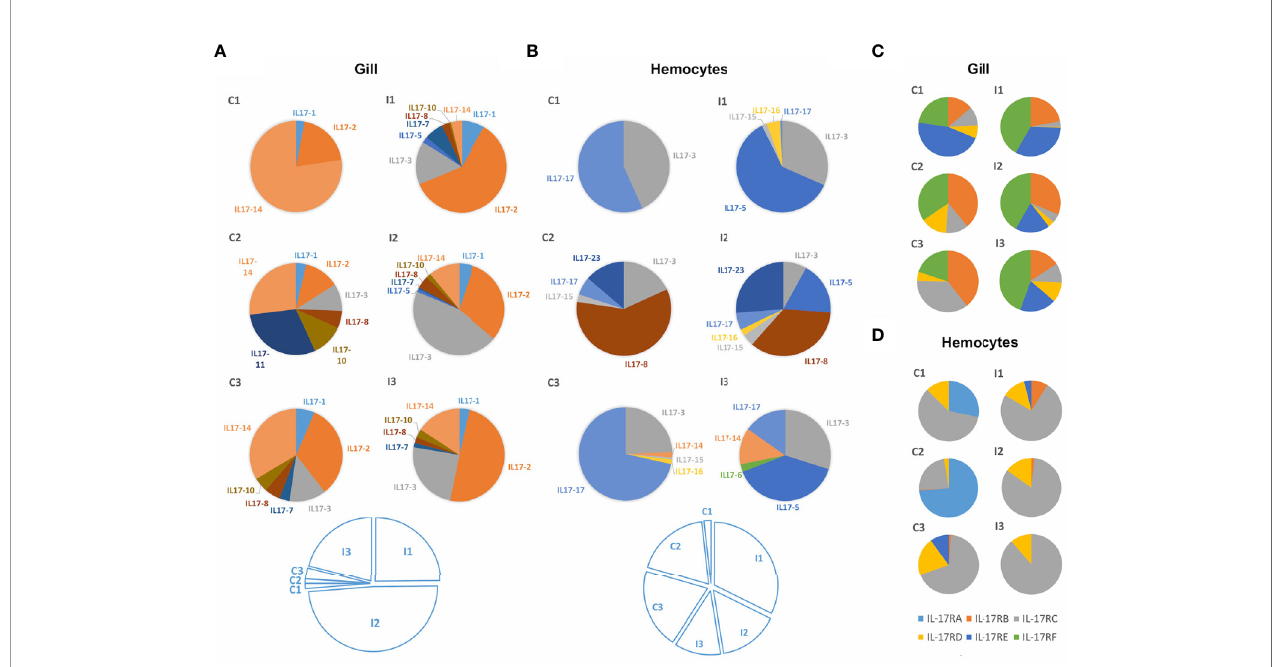
FIGURE 6 | Expression of the different mussel IL-17 isoforms in the gill transcriptome against a waterborne bacterial infection (A) and in the hemocyte transcriptome against a bacterial infection injected into the muscle (B) . It is shown that the isoforms expressed in each transcriptome changed completely. Colored pie charts represent the diversity of expressed IL-17 isoforms in each individual mussel from the control (C1, C2, C3) and infected conditions (I1, I2, I3). The white pie charts below represent, for each experiment, the weight that the expression values of each of the upper graphs have (calculated by the sum of the expression values of every IL-17 form for each of the individual samples). Clear upregulation of IL-17 expression is seen in the gill transcriptome against infection but not in the hemocyte transcriptome. Expression of IL-17 receptors in the same gill (C) and hemocyte (D) transcriptomes. Regarding the IL-17 receptors, it can be seen that the expressed isoforms also varied between transcriptomes.